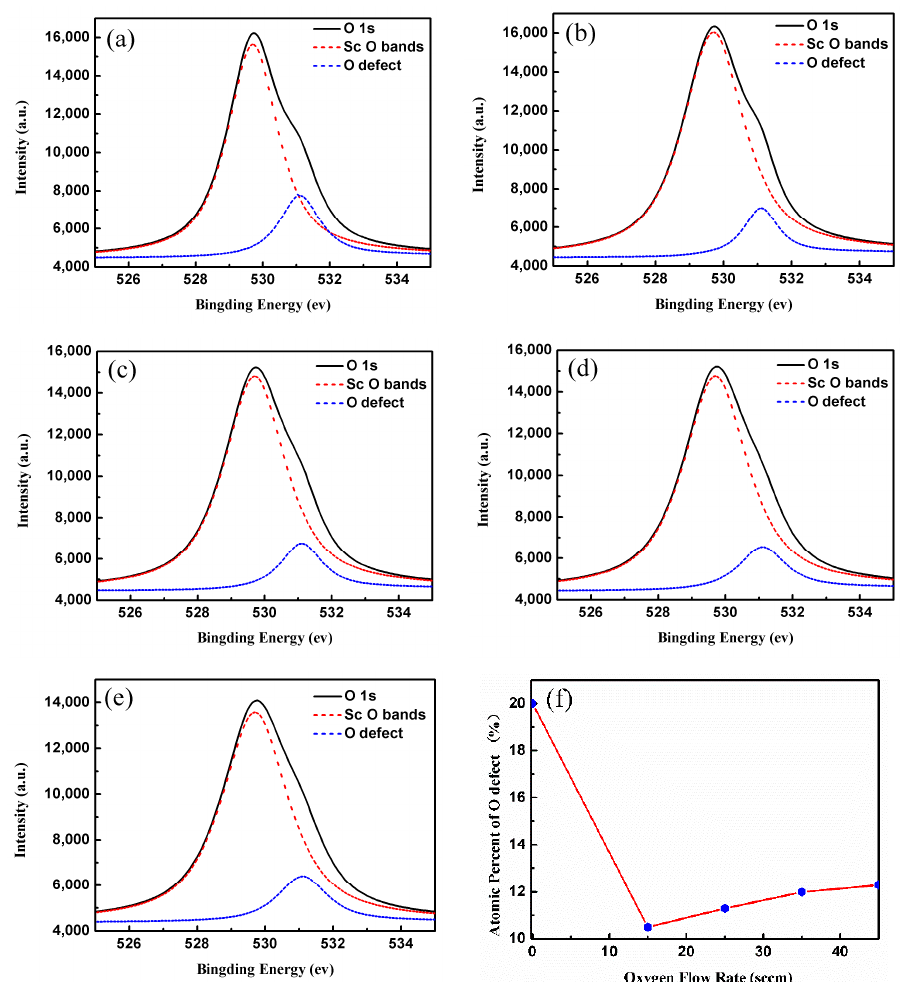
Figure 2. XPS spectra of Sc 2 O 3 films and the atomic percent of oxygen defect under different oxygen flow rates: ( a ) 0 sccm; ( b ) 15 sccm; ( c ) 25 sccm; ( d ) 35 sccm; and ( e ) 45 sccm; ( f ) Atomic percent of oxygen defect.